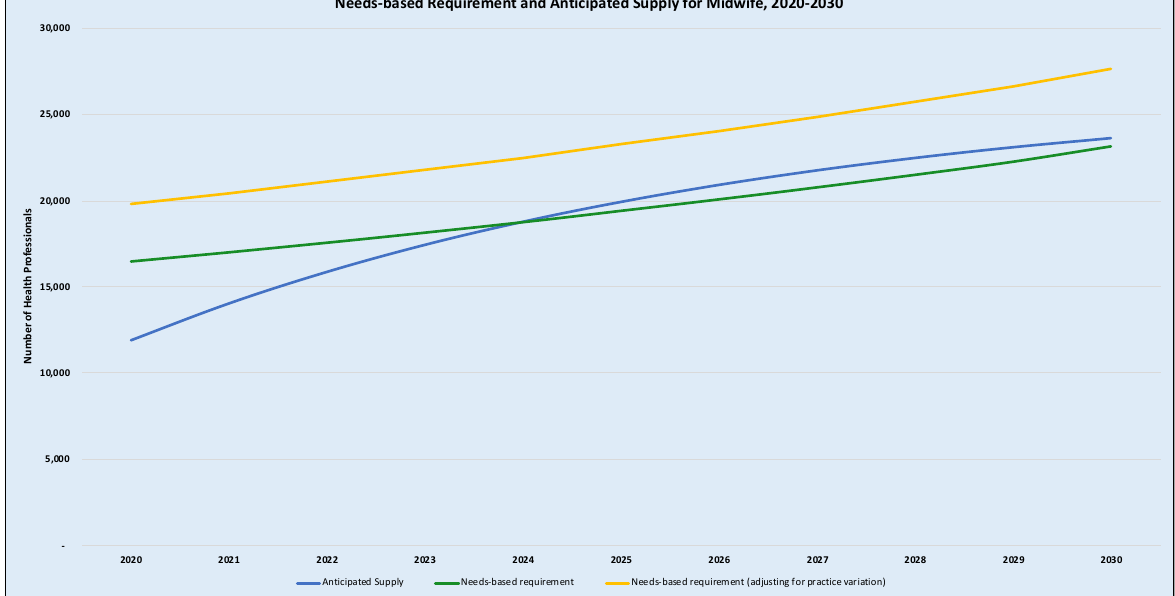
Figure 4. Exploring the effect of variations in activity standards on the needs-based requirements for midwives. Notes: Figure 4 illustrates the impact of practice variation on the projected trend of the need-based requirement of midwives (yellow line) as compared to the original trend (green line) and the anticipated trend of supply (blue line).